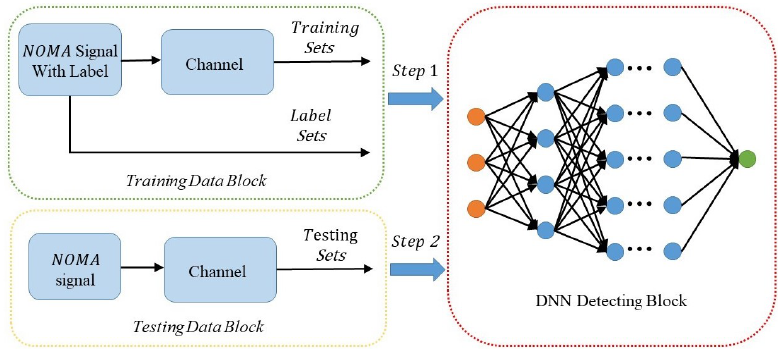
Figure 7. Construction of the MIMO-NOMA-DL model. DL: deep